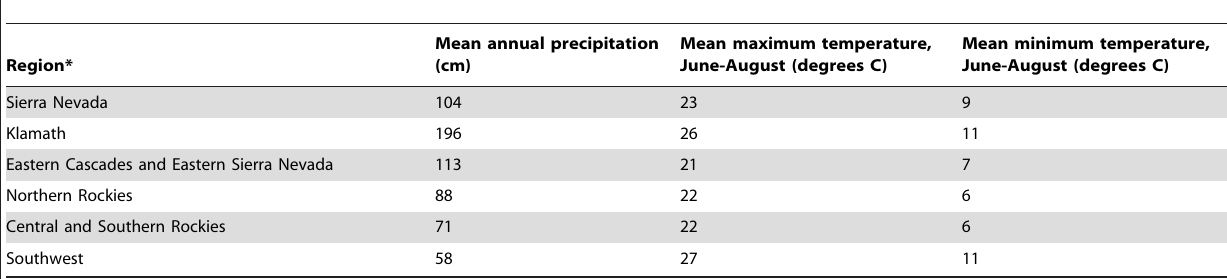
Table 3. Mean annual precipitation, and mean summer maximum and minimum temperatures, in ponderosa pine and mixed- conifer forests in each